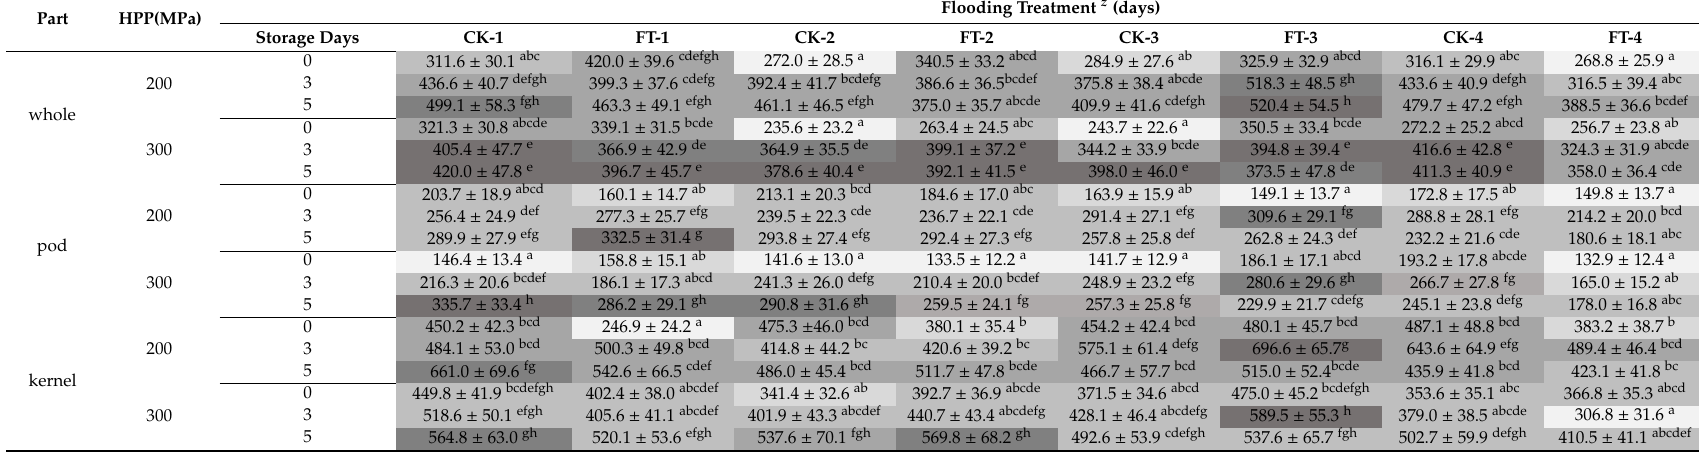
Table 5. The impact of flooding treatment with di ff erent high-pressure processing (HPP) treatment for 0, 3, 5 days of storage on the GABA content of ‘Kaohsiung 9’ whole vegetable soybeans, pods, and